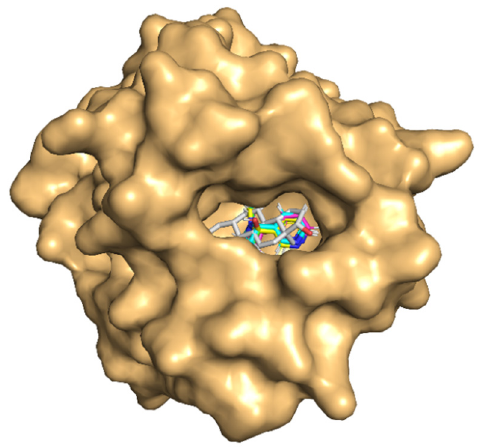
Figure 2. Self-docking analyses of the native ligands, i.e., dihydrotestosterone (DHT), cortisol, and thyroxine, respectively, for sex-hormone-binding globulin (SHBG), corticosteroid-binding globulin (CBG), and thyroxin-binding globulin (TBG). The ligand binding sites of the proteins are shown as a surface with light orange color. The docked pose of the native ligand is with a backbone colored in blue, whereas the original bound pose is with a backbone in white.